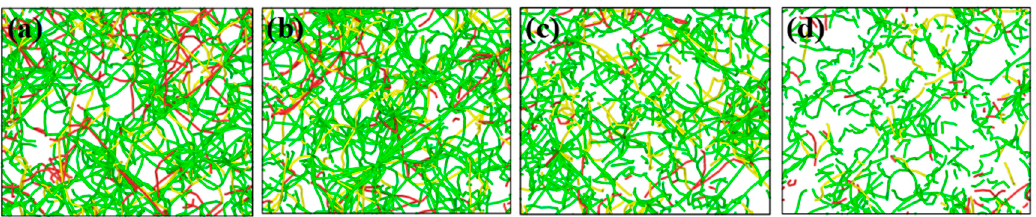
Figure 4. Dislocation distribution at 77 K ( a ), 300 K ( b ), 500 K ( c ), and 800 K ( d ) under the same strain rate.